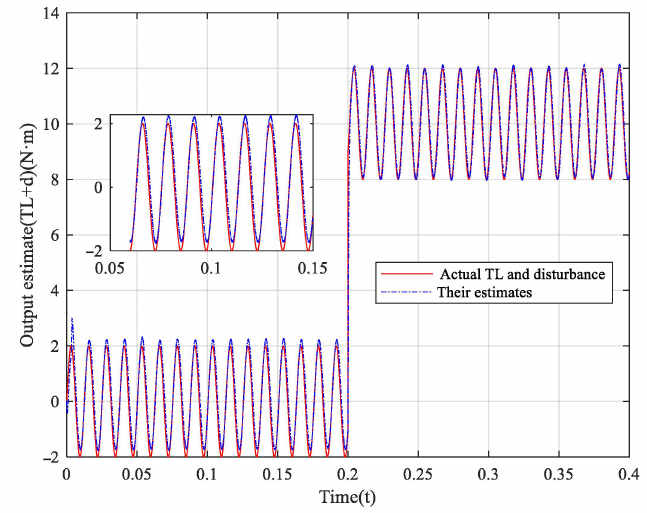
Figure 3. The actual load and disturbance with their estimates in low-speed